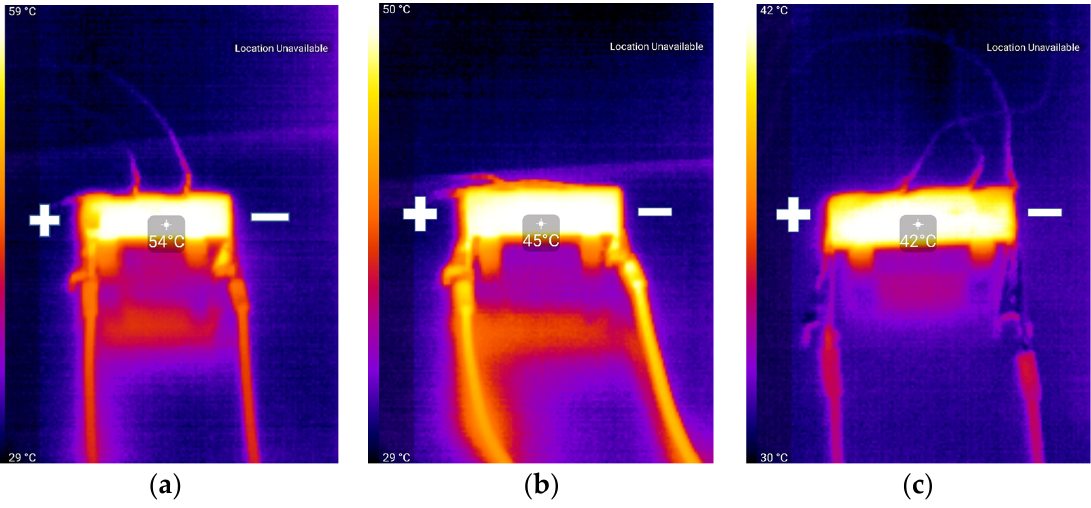
Figure 5. Thermal camera pictures at end of 2C discharge process: ( a ) NCA; ( b ) NMC; ( c ) LCO.